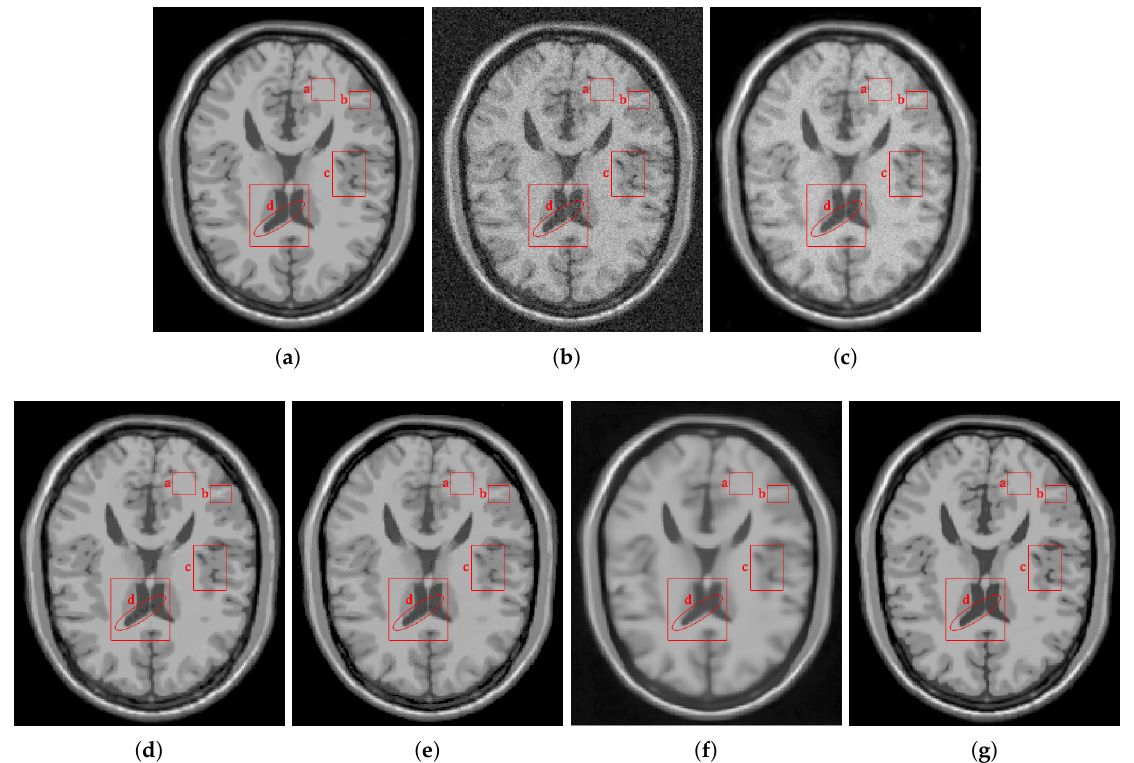
Figure 6. Comparison of the denoising methods on the T1w synthetic noise-free MR image corrupted with 5% Rician noise. ( a ) Original synthetic noise-free MR image. ( b ) Original image corrupted with 5% Rician noise. ( c – g ) Denoising results of the KSVD, PRINLM, BM4D, DnCNN, and the proposed method